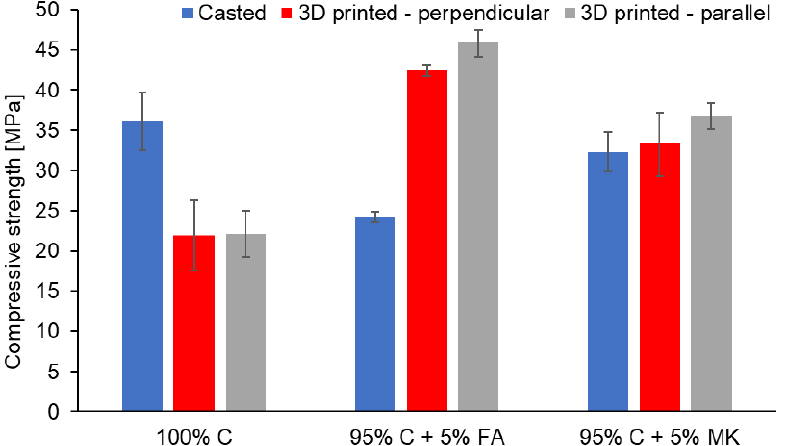
Figure 4. The compressive strength of concrete (100% C) and concrete-geopolymer hybrids based on fly ash (95% C + 5% FA) and metakaolin (95% C + 5% MK) that were cast and 3D printed. For 3D printed samples, the analysis was performed in the parallel and perpendicular direction to the Z -axis of the printout.